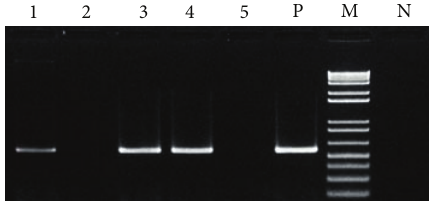
Figure 2: The result of PCR targeting ctxA using the plasmid DNA from GCDV 10-1 and the genomic DNA from V. cholerae N16961 (as control), with or without S1 nuclease treatment. Lane 1, GCDV 10-1 without S1 nuclease treatment; lane 2, GCDV 10-1 with S1 nuclease treatment; lane 3, V. cholerae N16961 without S1 nuclease treatment; lane 4, V. cholerae N16961 with S1 nuclease; lane 5, V. cholerae N16961 single-stranded DNA prepared by rapid cooling after heat denaturation with S1 nuclease; lane 6, V. cholerae N16961 (positive control); lane M, 100bp ladder size marker; lane P, PCR-negative